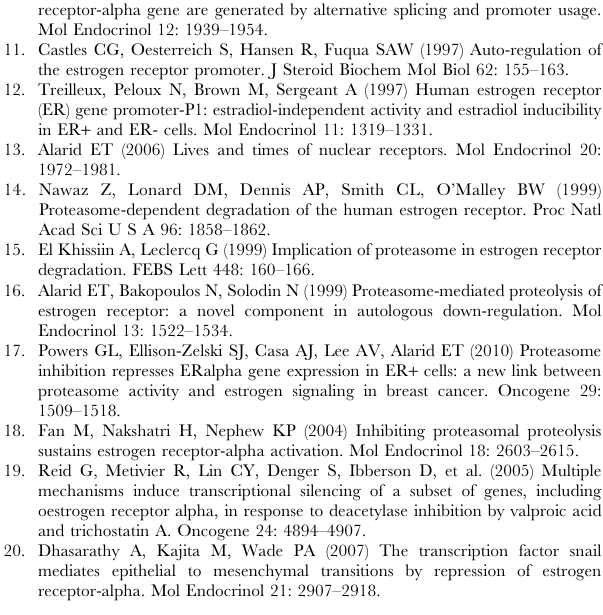
Table S1 Antibodies used for Western Blots. Primary antibodies to the indicated proteins of interest are listed with the specific clone in parenthesis. The Catalog number given is specific for the Company from which the antibody was purchased. The Concentration indicates the dilution of primary antibody in a solution of 5% milk that was used in the Western blot analysis. Table S2 Primers used for Quantitative Reverse Transcriptase PCR (qRT-PCR) of mRNA. Listed are the accession number, location and sequences of primers used for qRT-PCR. Temp. indicates the optimized annealing temperature used for each primer set. Table S3 Primers used for ChIP and DNAse sensitivity assays. Primers used in quantitative PCR analyses of ChIP and DNAse sensitivity assays for the ESR1 gene are shown. The name of the primer indicates its location based on base pair distance 5 9 of the TSS. Temp. indicates the optimized annealing temperature for each primer pair. Table S4 Antibody conditions for ChIP. Shown is a list of antibodies with corresponding catalog number and commercial vendor. Also included is the amount of antibody used for the indicated volume of lysate out of a total of 300 m l of total cell